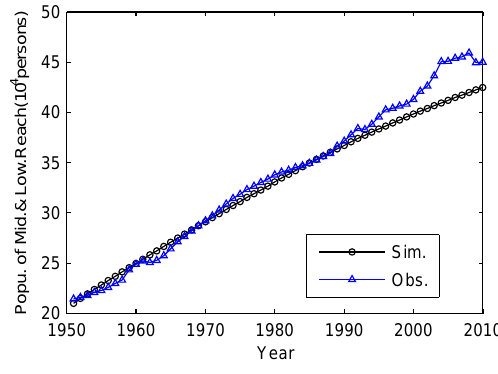
Figure 9. Ratio of irrigated area ( R I ) of the lower reach of the Tarim River.